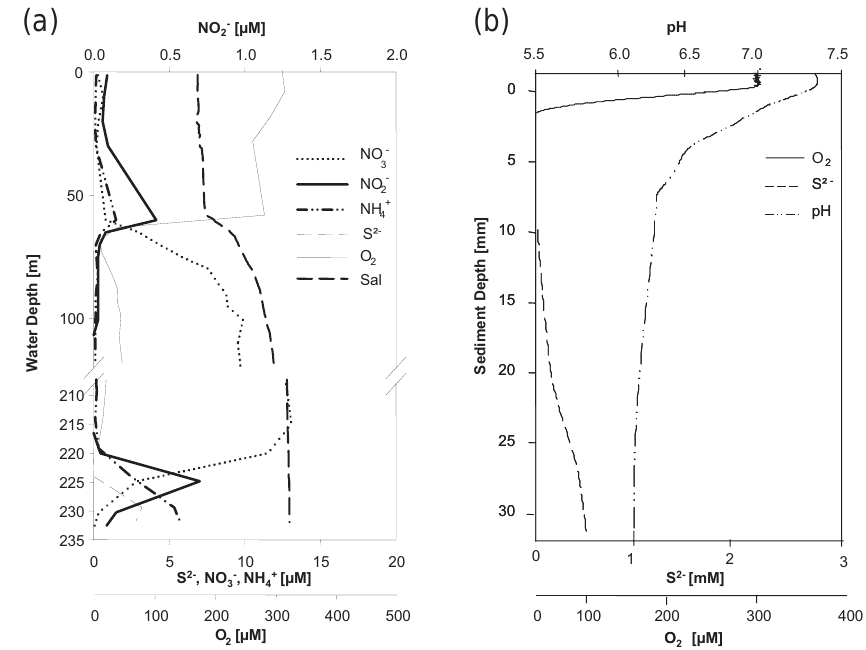
Fig. 2. Physical and chemical parameters of sampling sites in the Baltic Sea; (a) water column in the Gotland Deep, (b) coastal sediment in the